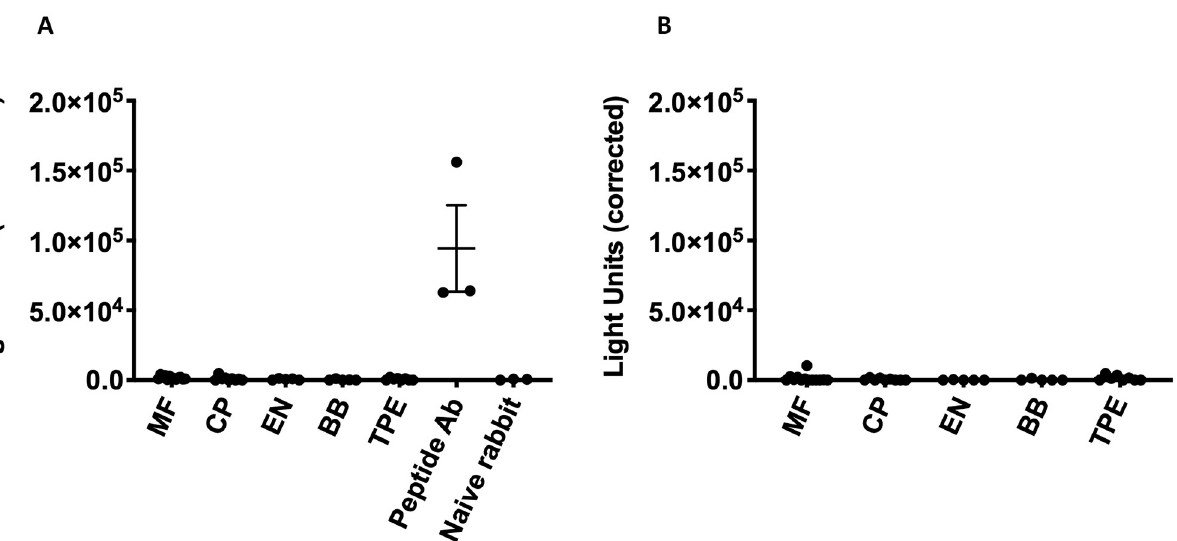
PLOS NeglectedTropical Diseases | https://doi.org/10.1371/journal.pntd.0007687 September 12,